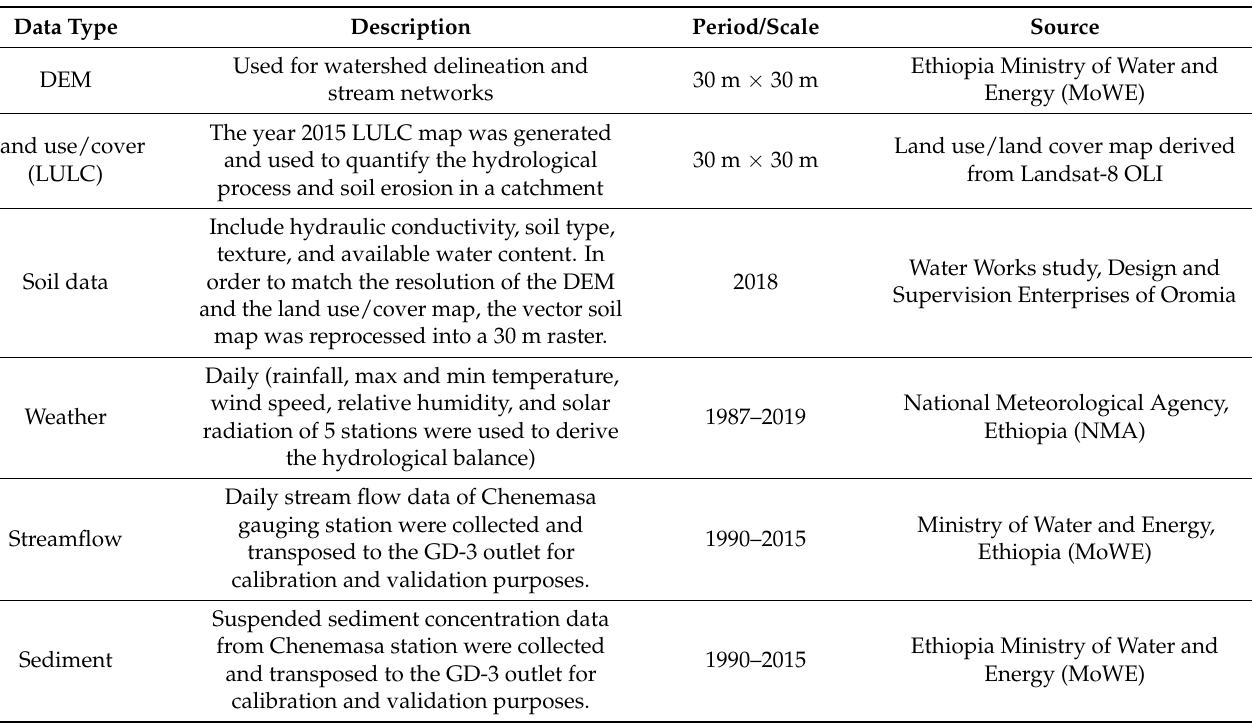
Table 1. Description of spatial and temporal data used for SWAT modeling in Genale Dawa-3 dam